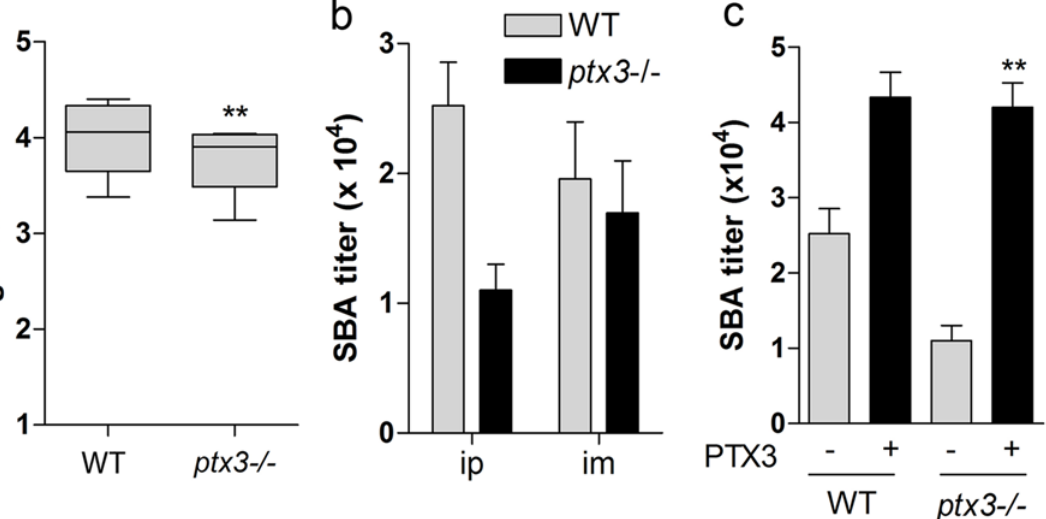
Fig 5. Bactericidal activity of serum from mice immunized with OMV. WT and ptx3-/- mice were immunized by ip or im treatment with OMV and sera were collected two weeks after the last immunization. Data are presented as mean SBA titres ± SD a) comparison of log SBA titres in WT and ptx3-/- mice ( ** p < 0.01, paired Student ’ s t test; pooled data from ip immunized animals). b) mean SBA titres in representative experiments performed in WT and ptx3-/- mice immunized ip (WT n = 8 ptx3-/- n = 6) or im (WT n = 15, ptx3-/- n = 16) with 0.05 (ip) or 0.5 (im) μ g OMV. c) mean SBA titres in WT and ptx3-/- mice immunized with 0.05 μ g OMV ± 2 μ g PTX3 [one out of three experiments; WT(OMV), n = 8; WT(OMV+PTX3), n = 7; ptx3-/- (OMV), n = 6; ptx3-/- (OMV +PTX3), n = 8]. * p < 0.5; ** p < 0.01 (Student ’ s t test).